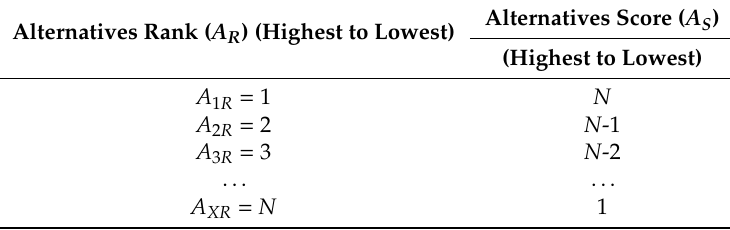
Table 2. Initial rank and score allocation for unanimous decision making